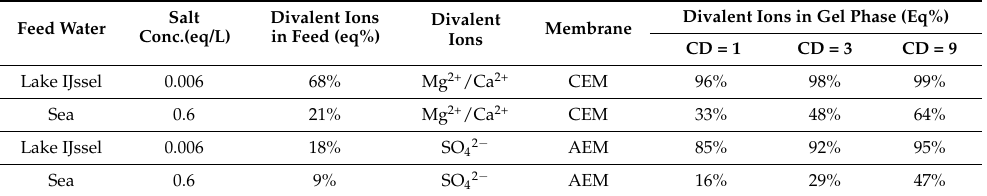
Figure 8. Calculated equivalent fraction of magnesium ions in cation exchange membranes as a function of the composition of the bulk water containing NaCl and MgSO 4 ; the membranes have charge densities if 1 mol/L ( left ), 3 mol/L ( middle ), and 9 mol/L ( right ). The different plots in each figure represent different bulk concentrations. Table 3. Equivalent percentage of divalent ions in membranes with different charge densities (CD): CD=1, CD=32, and CD= 9 Eq/L as function of the total salt concentration and divalent fractions in the feed waters.